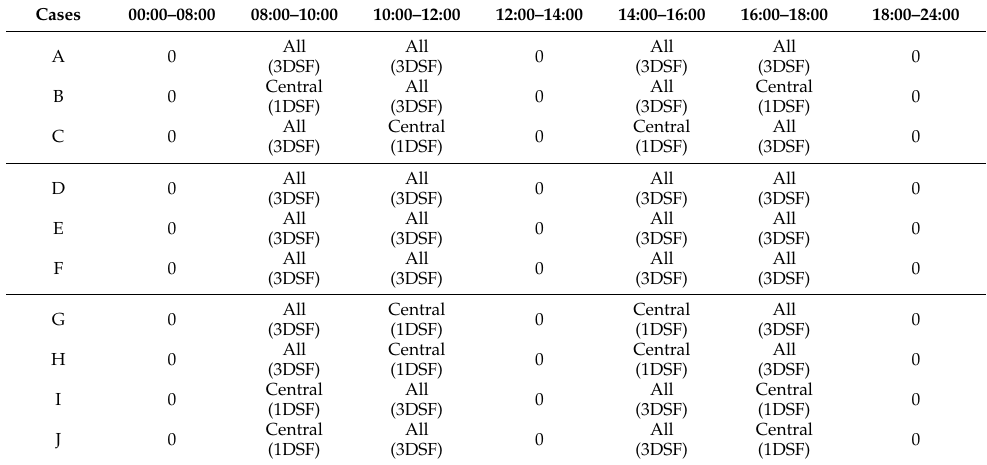
Figure 6. Scheme of the pre-programming horary control of the DSF system, when the airflow rate is variable and the number of DSF to operate is variable. Table 2. DSF used in each case study.